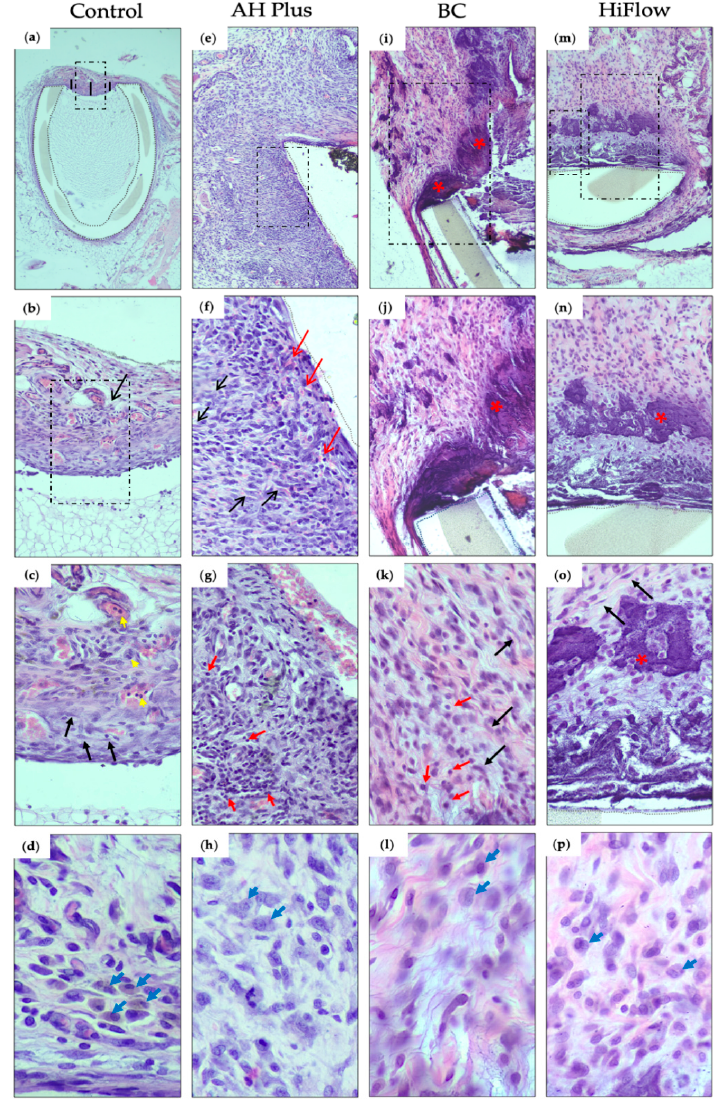
Figure 1. Hematoxylin and eosin histological sections of the interface tissue-sealer 8 days after subcutaneous implantation (dashed boxes mark the view of the subsequent image): ( a ) control group, evidencing the thin fibrous capsule at the interface between the host tissue and the polyethylene tube (demarcation with dotted lines), measured in 3 points (represented by the black lines) (40 × magnification); ( b ) the fibrous capsule and mild inflammatory reaction (score 1) (black arrow) at the interface tissue-sealer (200 × ); ( c ) high magnification showing in detail the cellular population consisting of polymorphonuclear leukocytes (neutrophils) (yellow arrows) and fibroblasts (black arrows) (400 × ); ( d ) macrophages (blue arrows) (800 × ); ( e ) AH Plus group, showing granulation tissue surrounding the polyethylene tube (demarcation with dotted lines) (100 × ); ( f ) high magnification evidencing small congested neo-capillaries (red arrows), fibroblasts (black arrows) and moderate inflammatory reaction (score 2) (200 × ); ( g ) high magnification, showing the inflammation with mainly lymphocytes (red arrows) and neutrophils (400 × hematoxylin and eosin (H&E)). ( h ) Macrophage infiltration (blue arrows) (800 × ); ( i ) TotalFill BC Sealer (BC) group, showing a fibrous capsule with calcification (bluish deposits) (red asterisk) (100 × ). ( j ) Higher magnification showing fibroblasts and some inflammatory cells (score 1) and the calcified area in more detail (red asterisk) (200 × ). ( k ) Fibroblasts (fusiform cells) (black arrows) in a stroma with some collagen fibrils and some lymphocytes (red arrow), plasma cells and rare neutrophils (400 × ). ( l ) Macrophage infiltration (blue arrows) (800 × ); ( m ) HiFlow group, revealing a fibrous capsule with calcification next to the polyethylene tube (100 × ); ( n ) higher magnification to observe fibroblasts, and inflammatory cells (score 1) next to the calcified area (red asterisk) (200 × ); ( o ) calcified area (red asterisk), with fibroblasts (fusiform cells) (black arrows) in an edematous and low collagenous stroma with lymphocytes (400 × ); ( p ) macrophage infiltration (800 × ). ( n =